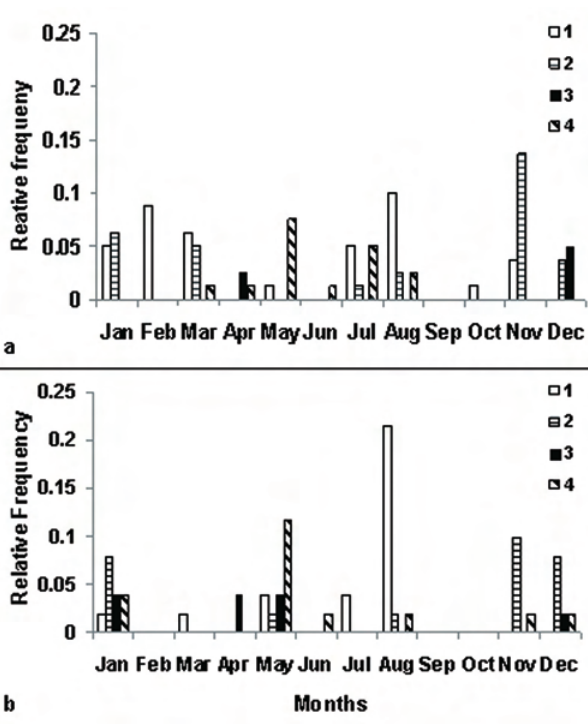
Fig. 6. Monthly distribution of frequency of gonadal maturation stages of females (a) and males (b) of Cichla kelberi in the Lobo reservoir during the study. (Legend: 1- Resting; 2- In Maturation; 3- Spawning and 4- Spent).